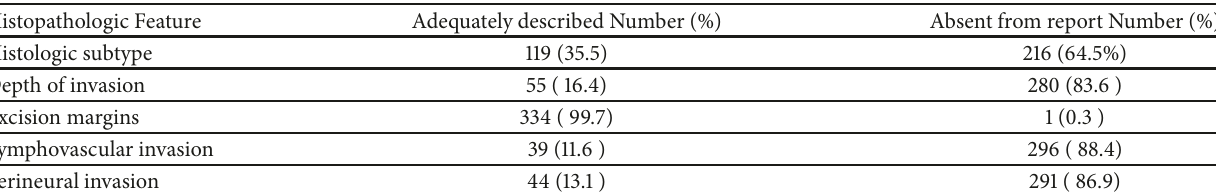
Figure 1: Subtypes of BCC: terminology and numbers. ∗ Others: cystic, fibroepithelioma of pinkus, invasive, keratotic, microcystic, micronodular. Table 2: Histopathologic features in reports of